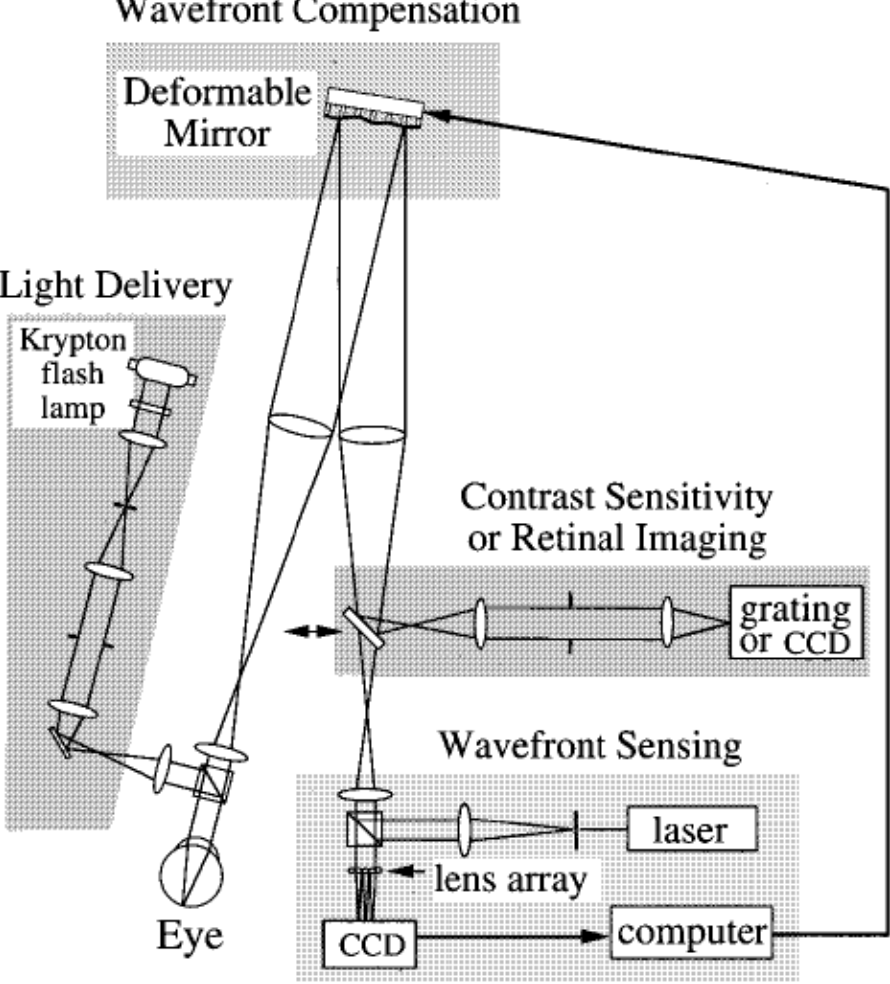
Figure 17. The adaptive system proposed by Williams et al. Figure reprinted with permission from Ref. [95] © The Optical Society.